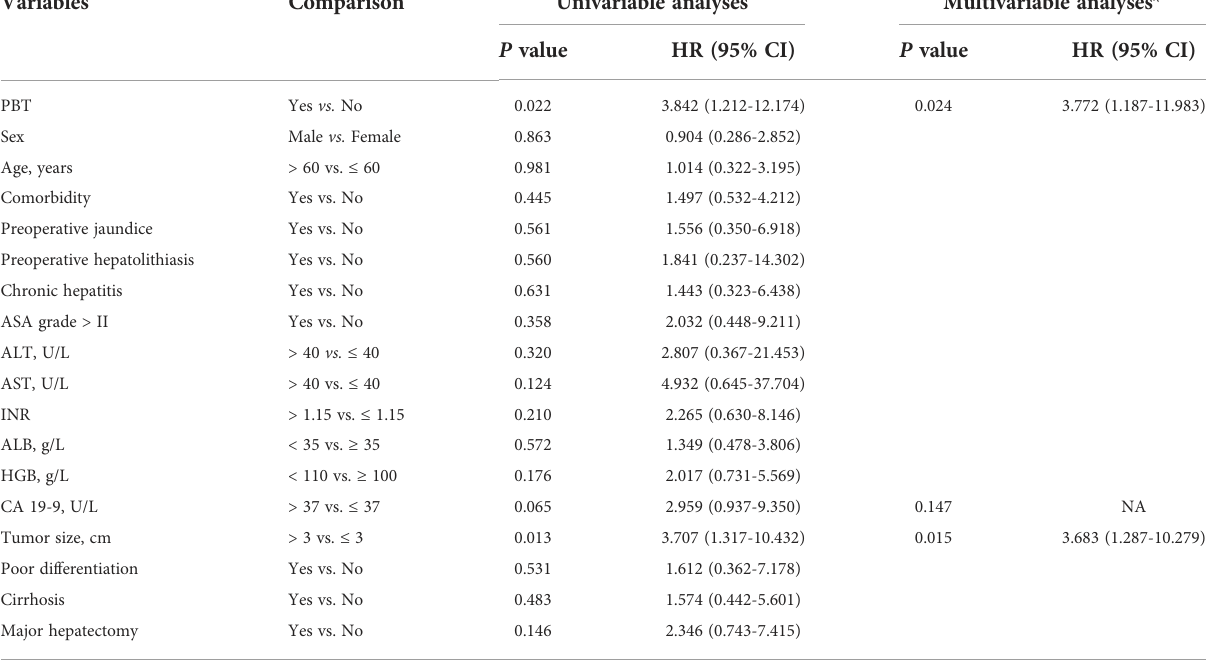
TABLE 3 Univariable and multivariable analyses of independent risk factors for overall survival among patients with early stage (8th AJCC stage I) pCCA treated with curative resection after propensity score matching.